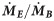
Comparison of bacterial colony structure for different values of M˙E/M˙B.Plots for cases (a) M˙E/M˙B = 2 (Case A-2), (b) M˙E/M˙B = 4 (Case A-3), and (c) M˙E/M˙B = 8 (Case A-4), are captured when the total number of cells is around 5000. Top: Bacterial cells colored by their sizes. Bottom: The iso-surfaces of the EPS production rate m˙E=1 ng/h, with contour lines and colors to indicate the height above the y = 0 surface.